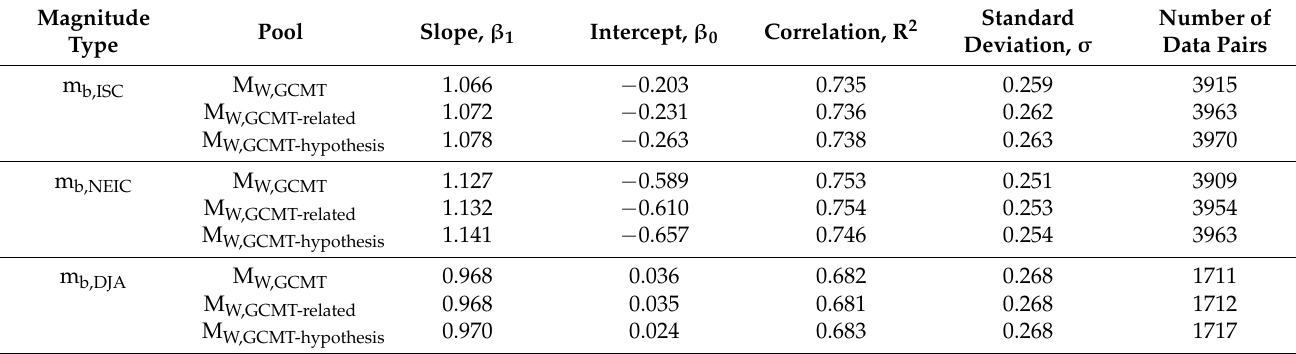
Table 5. Magnitude homogenization regression results from all moment magnitude pools for body wave magnitude